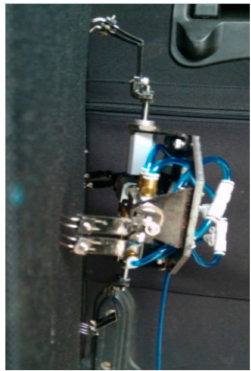
Figure 13. The grabbing